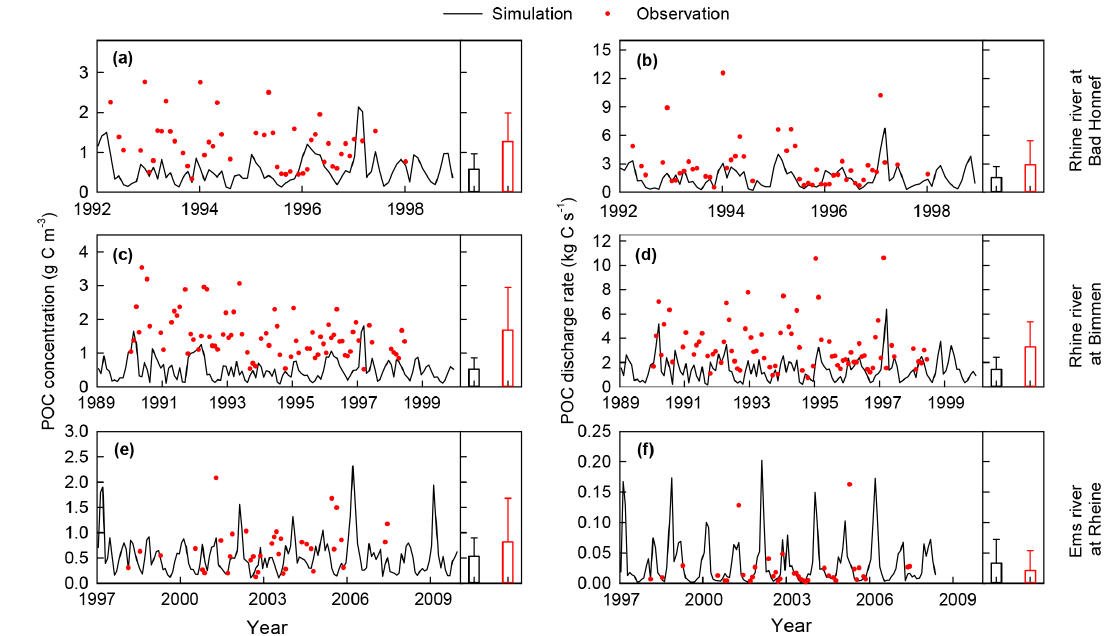
Figure 7. Comparison between observed (instantaneous measurements) and simulated (monthly average values) riverine POC concentrations and POC discharge rates at three gauging sites. The histograms and error bars denote the means and standard deviations of POC concentra- tions, respectively. Long-term average water discharge rates at Bad Honnef, Bimmen and Rheine during the observation periods are 2023, 2100 and 80m 3 s − 1 , respectively.